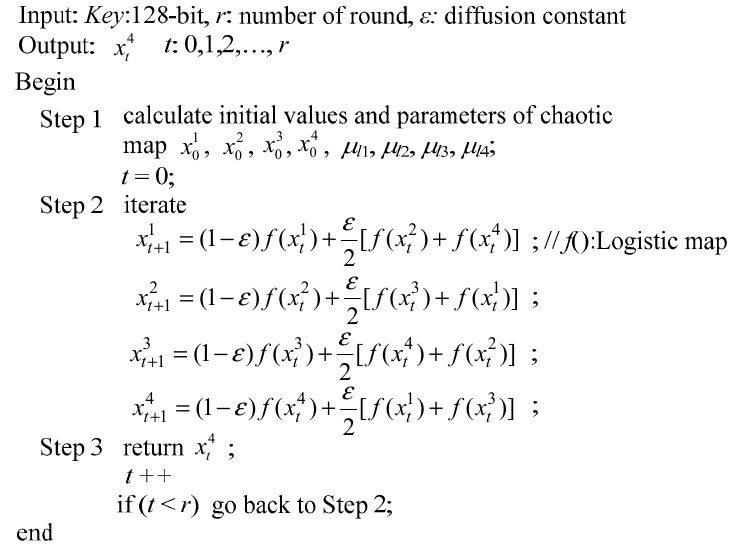
Figure 3. Simulation algorithm for original CML.